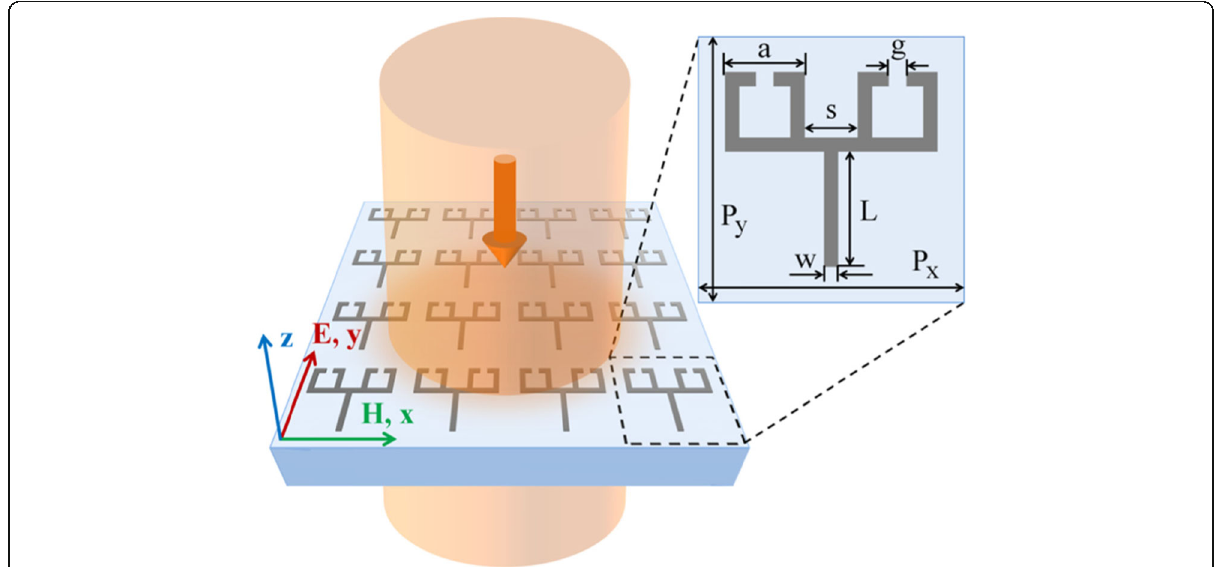
Fig. 1 Schematic of the conductively coupled terahertz EIT